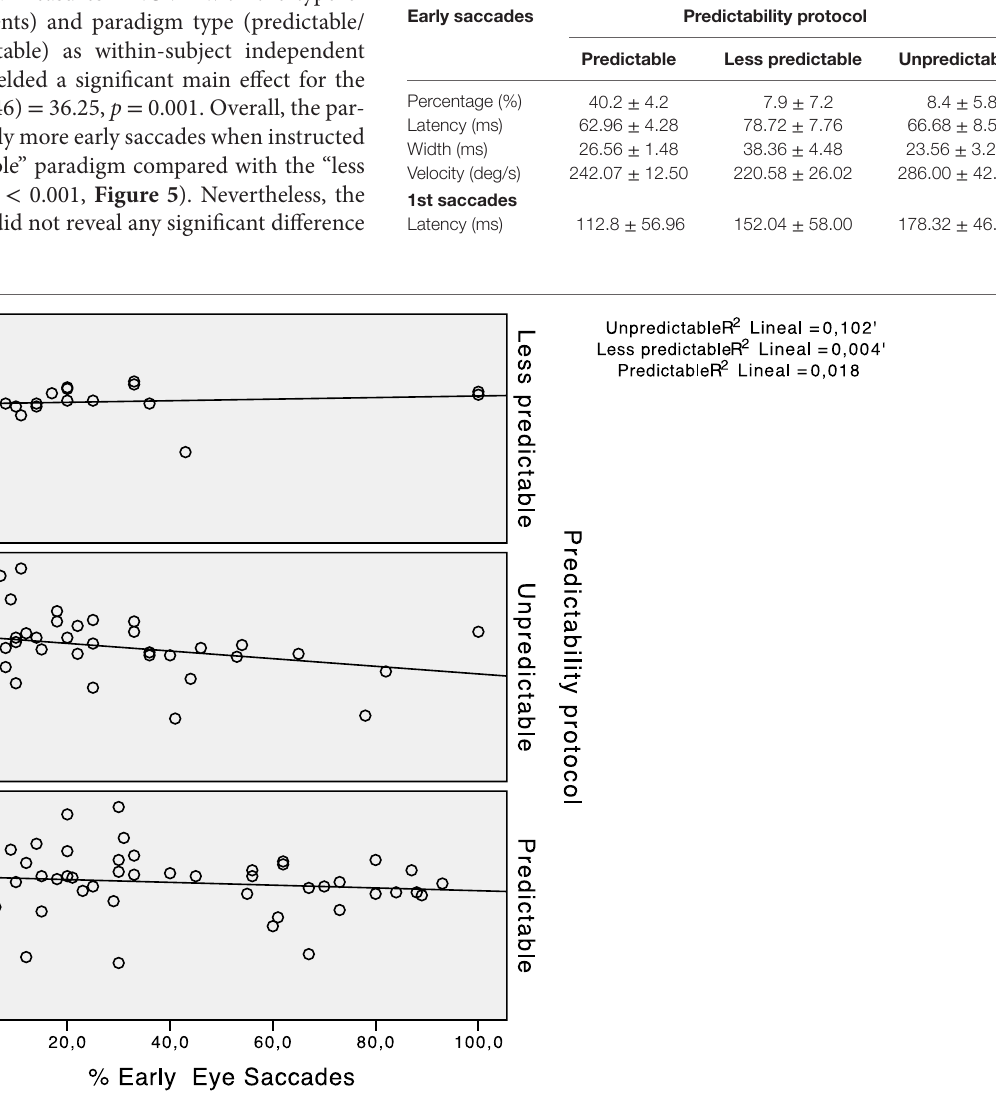
FigUre 6 | Scatter plots representing the relationship between horizontal vestibulo-ocular reflex (hVOR) gain and the percentage of early saccades in every predictability protocol